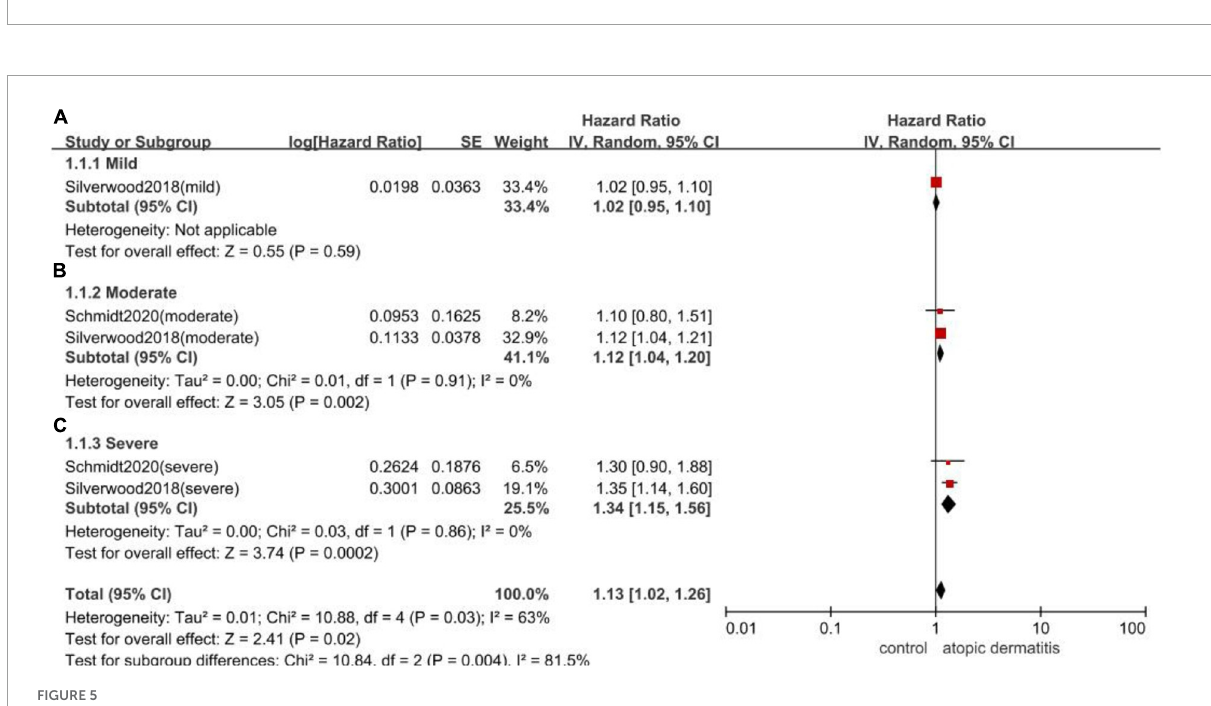
FIGURE5 Forest plot of subgroup analyses by the severity of atopic dermatitis. (A) : the association of mild patients with atopic dermatitis and the risk of subsequent AF (HR 1.02, 95% CI 0.95–1.10); (B) : the association of moderate patients with atopic dermatitis and the risk of subsequent AF (HR 1.12, 95% CI 1.04–1.20, I 2 = 0%); (C) : the association of severe patients with atopic dermatitis and the risk of subsequent AF (HR 1.34, 95% CI 1.15–1.56 I 2 =